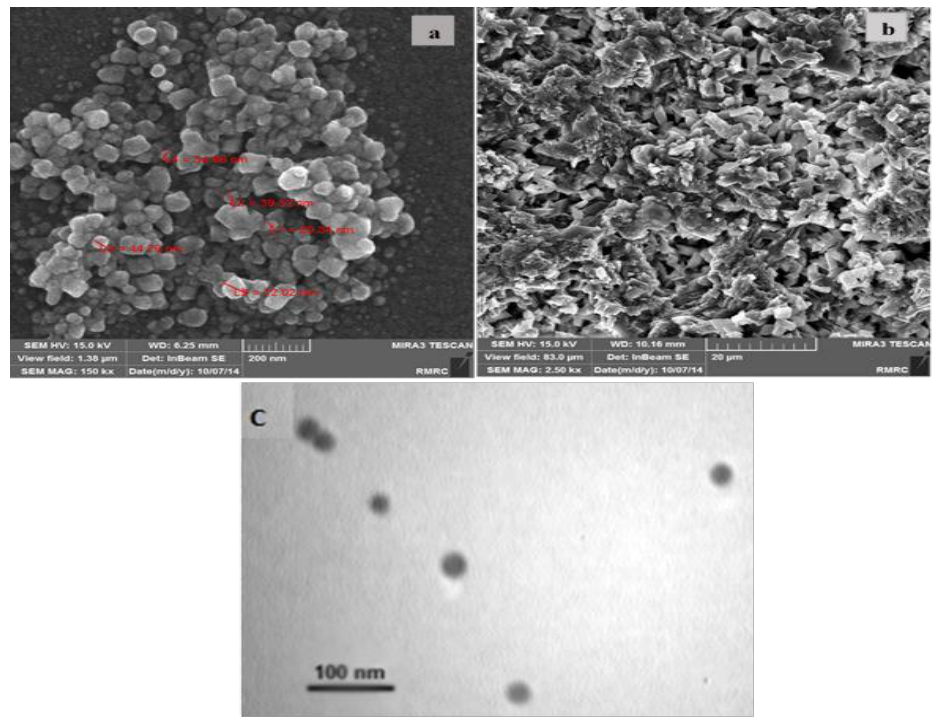
Figure 1. SEM images of the morphology of ( a ) silver-nanoparticles/graphene-oxide-modified screen-printed electrode (SNPs/GO/SPE), ( b )oracet-blue/silver-nanoparticles/graphene-oxide-modified screen-printed electrode (OB/SNPs/GO/SPE) and ( c ) the TEM image of SNPs.